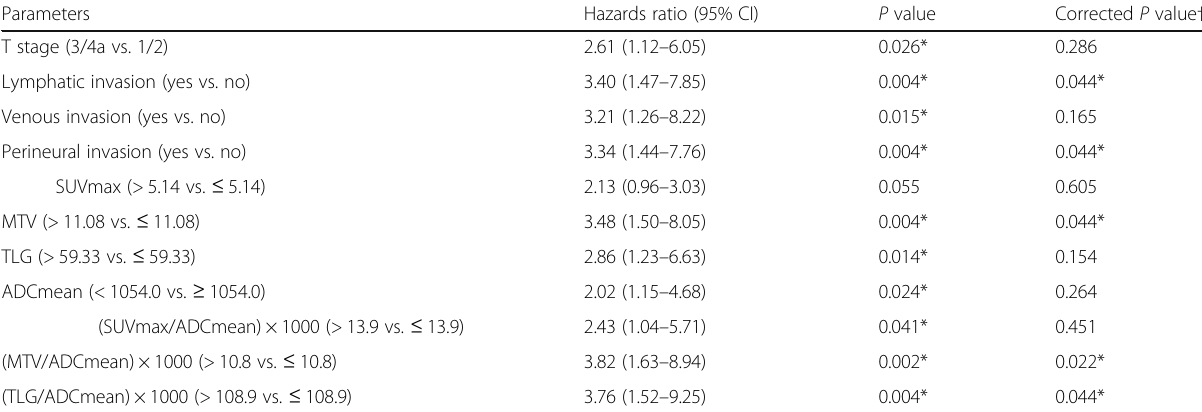
Table 4 Univariate analysis with clinicopathologic and 18 F-FDG PET/MRI parameters Parameters Hazards ratio (95% CI) P value Corrected P value †